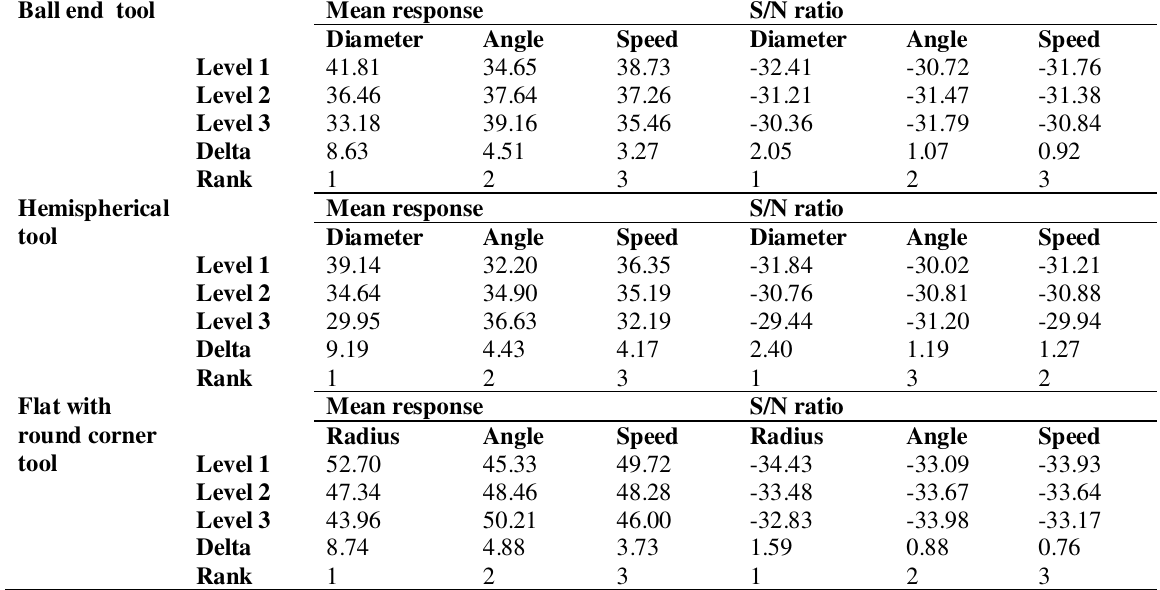
Results for individual characteristic of mean response and S/N ratio Ball end tool